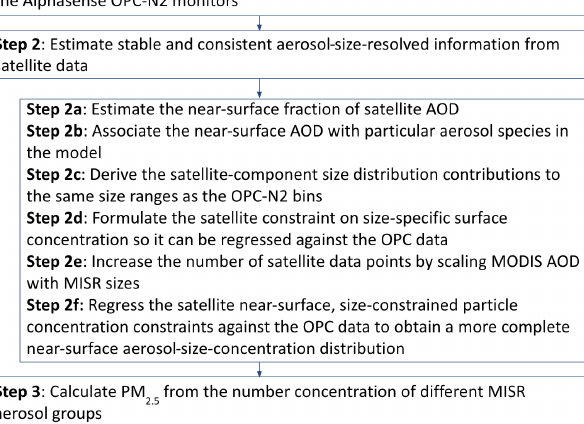
Figure 1. An overview of the proposed